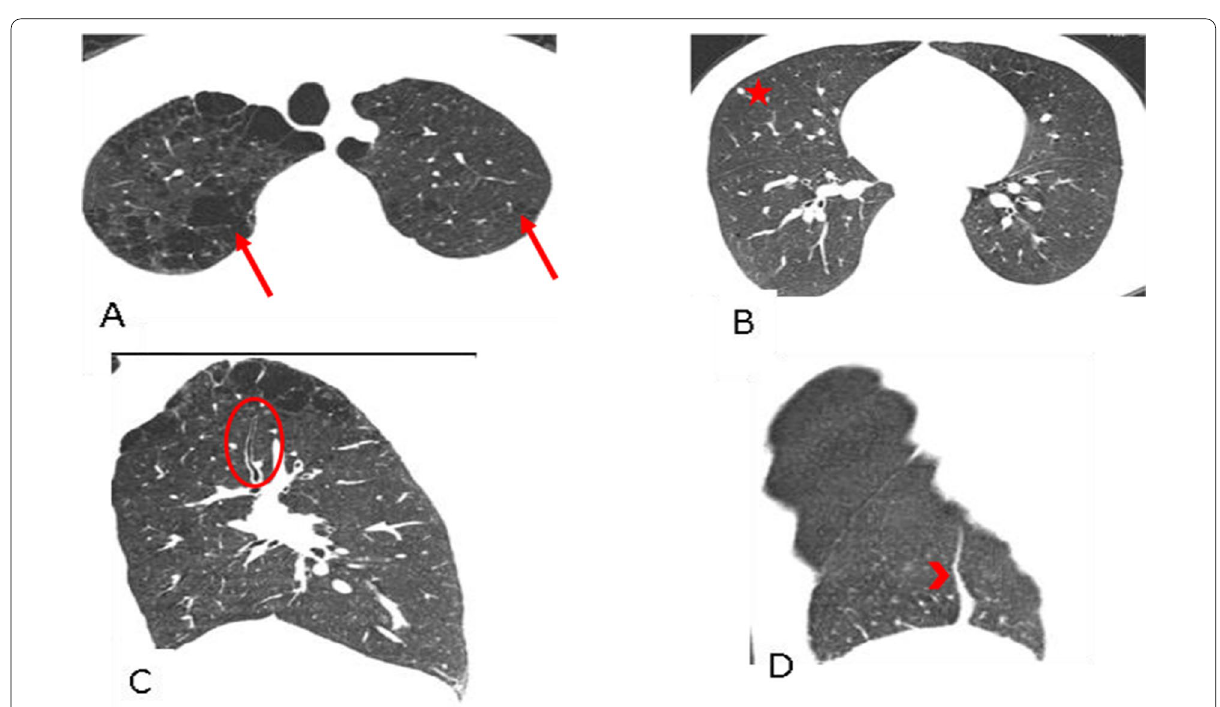
Fig. 1 a – c Axial HRCT of 33‑year‑old male (10 years disease duration) showing bilateral para‑septal and centrilobular emphysema (arrows) ( a ), right middle lobe nodule (asterisk), hyperinflation, hyper‑lucency ( b ). c , d Sagittal reformatted HRCT image showing bronchial thickening (circle) ( c ) and lower lobe fibrotic changes (arrowhead) ( d